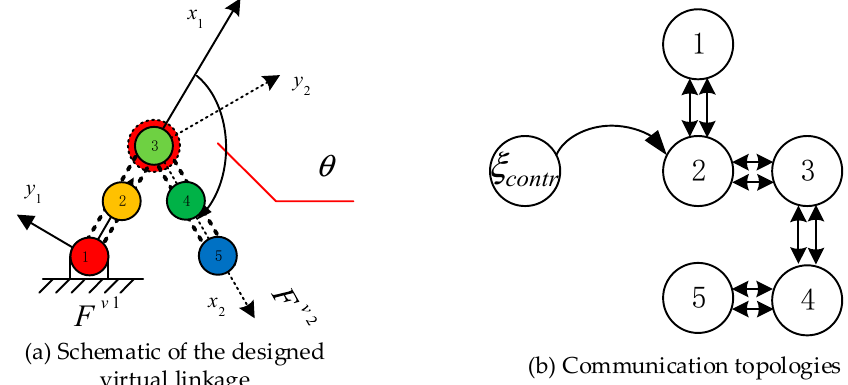
Figure 13. Schematic of designed virtual linkage and communication topologies.